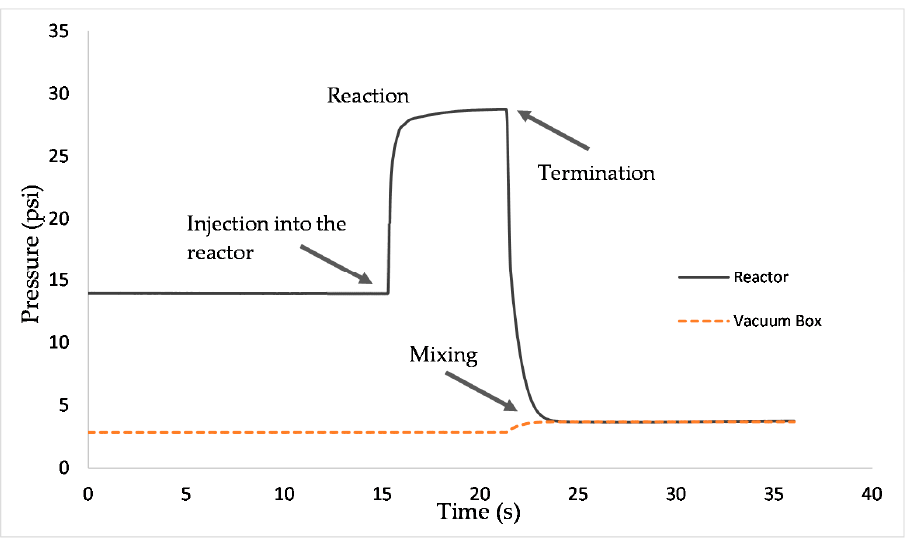
Figure 9. Pressure profile in the CREC riser simulator for a tar cracking reaction at 5 s, S/B (Steam/Biomass) = 1.5, and 500 °C.